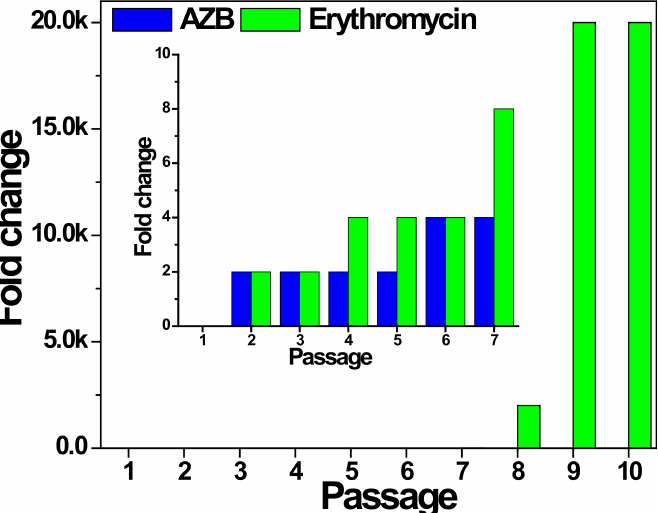
Figure 8. Acquisition of resistance by the treatment of AZB and erythromycin against S. aureus ATCC 25923 cells after multiple passages of growth. The fold change of minimum lethal concentration (MLC) (MLC i+1 / i , where i is the passage of growth from 1 to 9) for AZB and erythromycin with the pressure of their sub-lethal concentration (0.5 MLC) was regarded as the indicator for the development of drug resistance. The inset displays the enlarged region including passages 1–7. Experiments were performed in triplicates and showed the same results in all experiments. The values are also indicated in Table 1. Table 1. Antibacterial activity comparison of ( a ) erythromycin (Ery) against S. aureus (SA) ATCC 25923 cells and the AZB samples against ( b ) SA ( c ) MRSA5, and ( d ) ERSA cells. Fold Change Passages